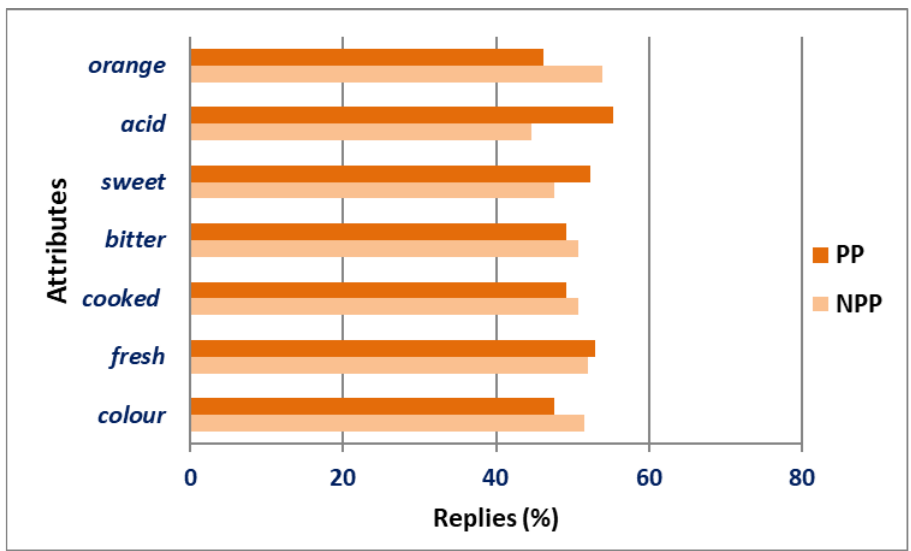
Figure 4. Discriminative results of attributes from non-pasteurized pulp (NPP) and pasteurized pulp (PP) evaluated by sensory panel.